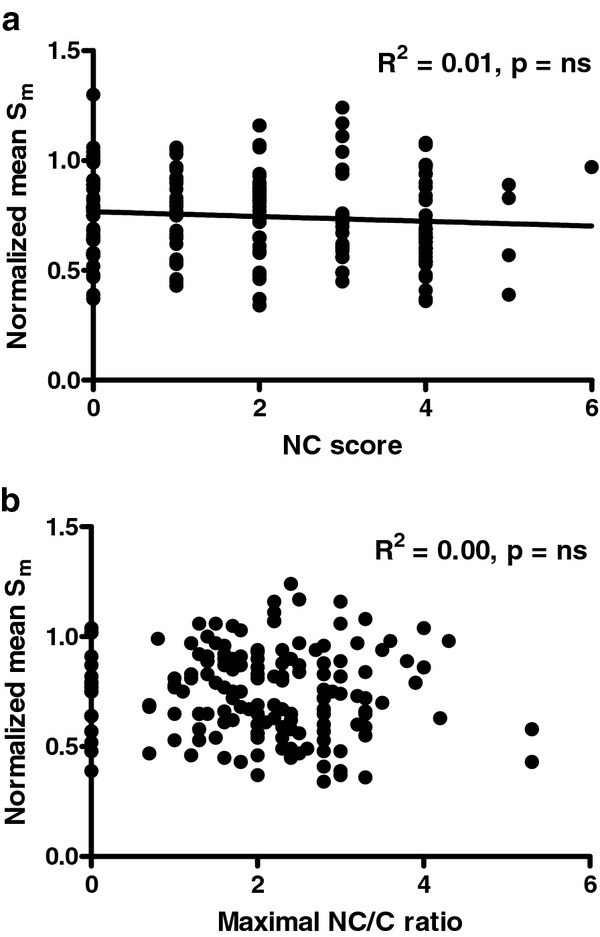
Relation between normalized systolic mitral annular velocities (Sm) and the total noncompaction score (4a), and the maximal noncompaction score (4b) in individual LV walls.